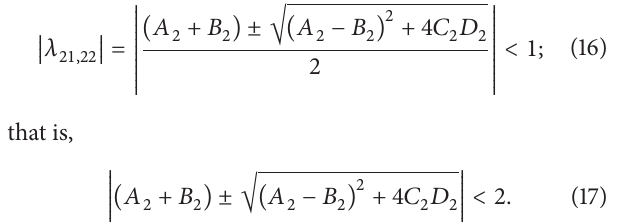
And the characteristic equation